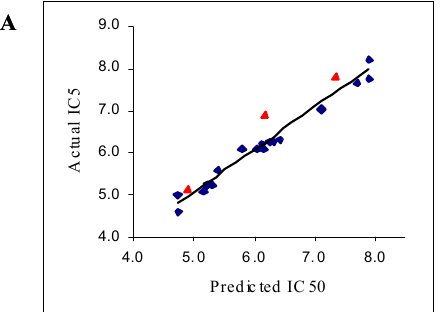
Figure 1. ( A ) Relationship between the actual and predicted logIC values for the 50 CYP1A1. Data points representing the test compounds that were not included in the training set of the QSAR analysis are colored red; ( B ) CoMFA contour maps for the most active compound 3'-propargyloxy flavone against CYP1A1. Steric desirable and undesirable contours are colored green and yellow; +ve charge and − ve charge desirable contours are colored blue and red; ( C ) CoMFA contour maps with 5-fluoro-3',4',5'- trimethoxybenzothiazole, elecstrostatic and steric fields of Model 1 [(1) & (2)], and Model 2 [(3) & (4)]. (Figure adapted from reference [33]); ( D ) and ( F ) Relationship between the inhibitor concentration and heme-C distance for CYP enzymes 1A1, and 2B1; ( E ) Relationship between the inhibitor concentration and distance between centroids of aromatic rings of phenylalanine residues and inhibitor for CYP enzyme